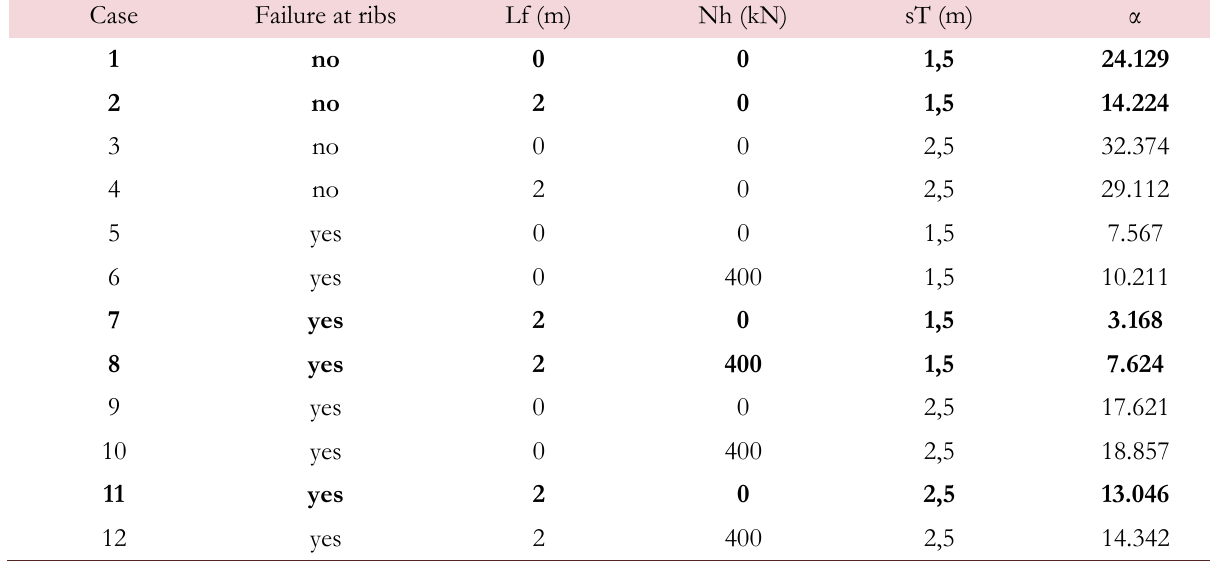
Table 1: Examined